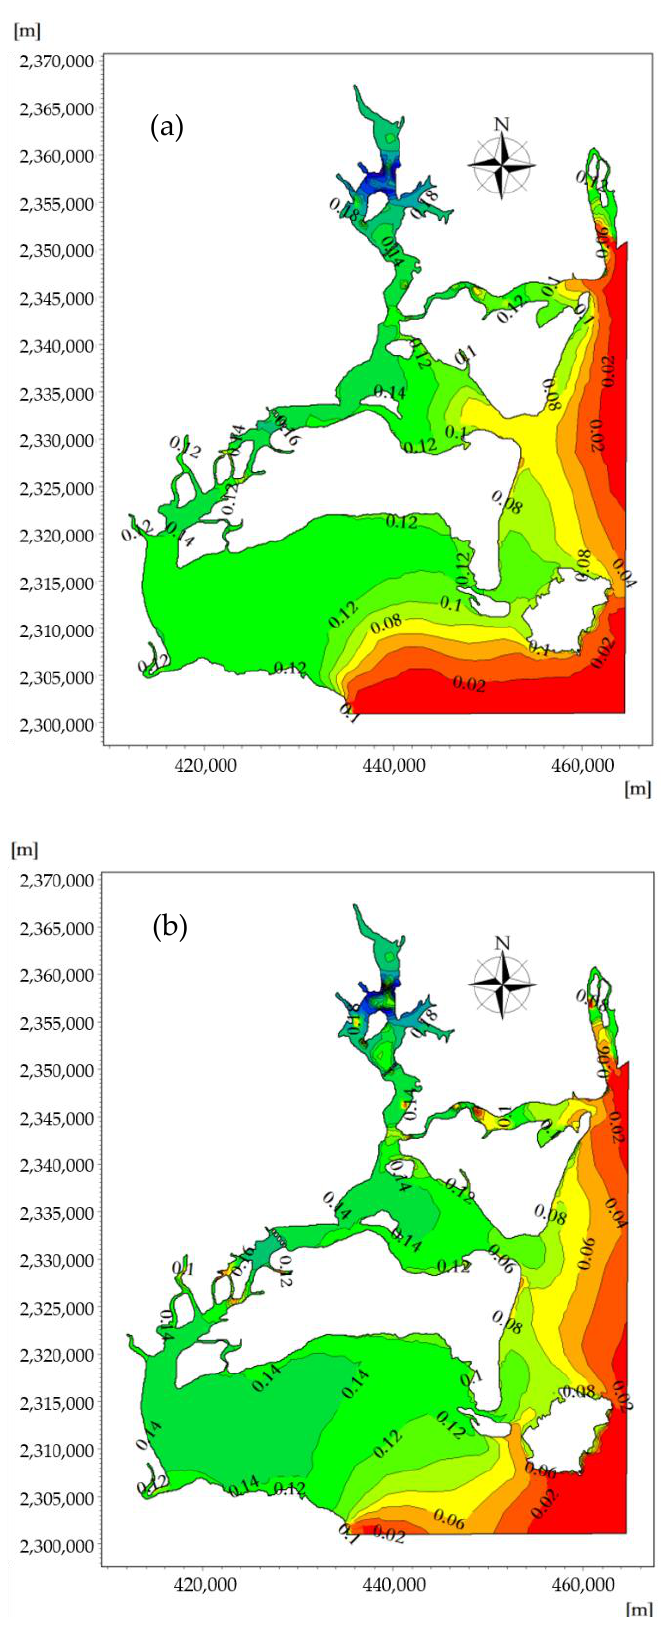
Figure 12. The spatiotemporal distribution of phosphorus concentrations across the modeling domain at the moment when the velocity of the flood tide ( a ) and ebb tide ( b ) reaches its maximum (mg/L).